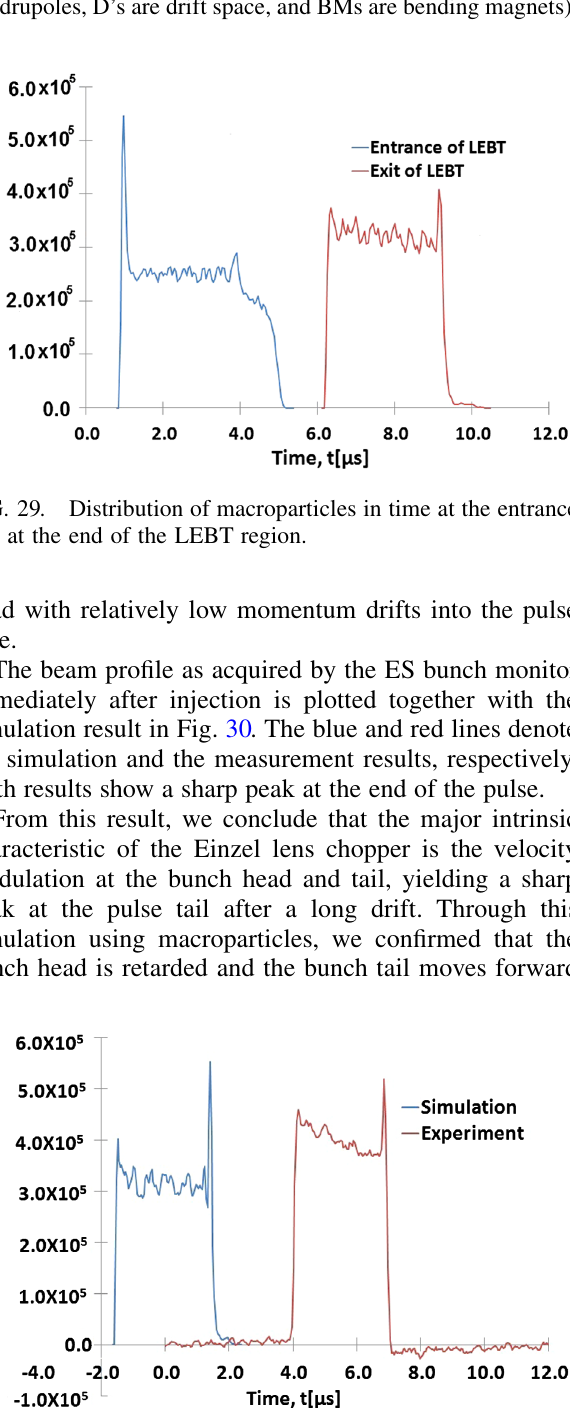
FIG. 28. Lattice components of the LEBT region (Q’s are quadrupoles, D’s are drift space, and BMs are bending magnets).